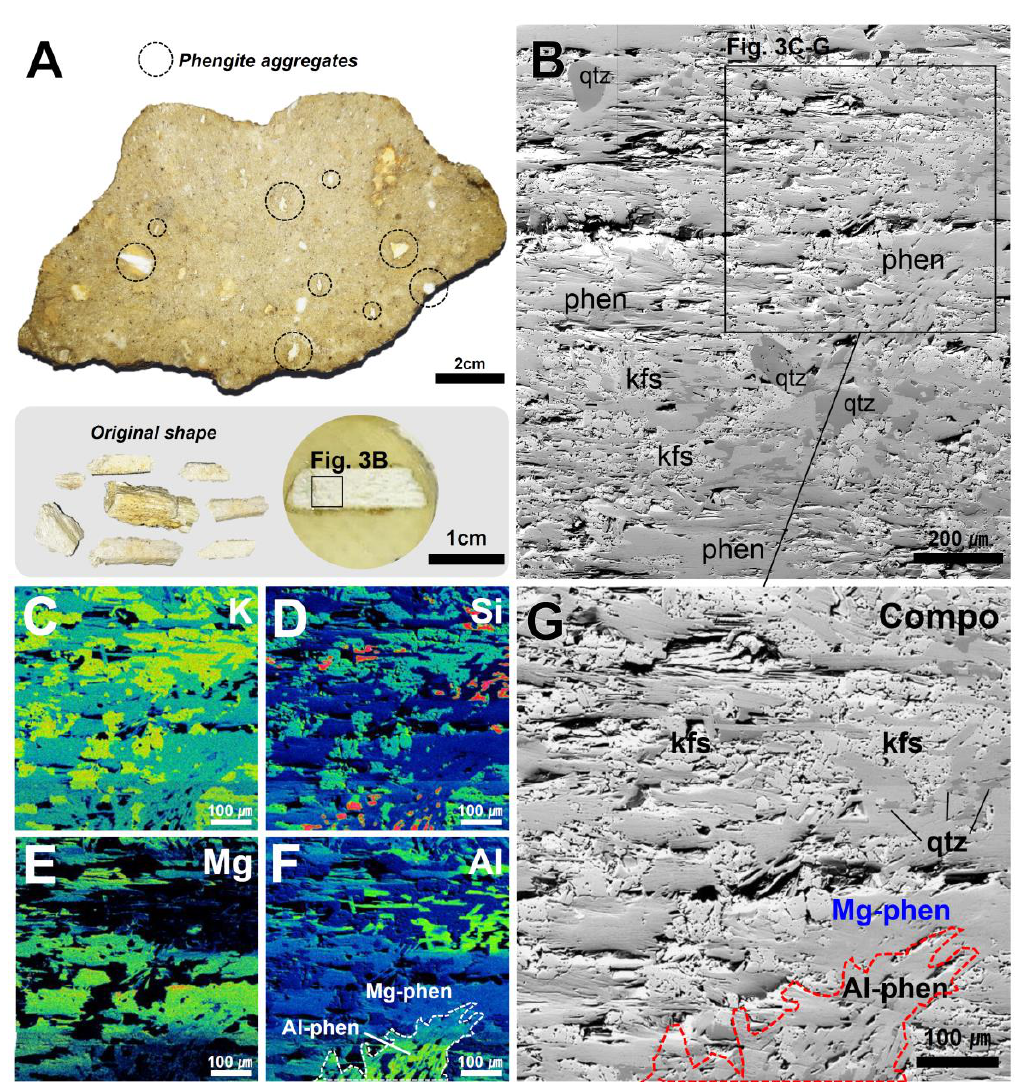
Figure 3. ( A ) Typical phengite aggregates scattered on the polished slab of the typical Haengmae Formation and the separate ones; ( B ) BSE image of the representative phengite aggregate, which is mainly composed of polycrystalline phengite (Type 1) with several hundred micrometers in size with a small amount of quartz and K-feldspar. Element-mapping results of the selected area for ( C ) K, ( D ) Si, ( E ) Mg, and ( F ) Al; ( G ) exaggerated BSE image of the selected part from ( B ). Abbreviations: qtz—quartz; kfs—K-feldspar; Mg-phen and Al-phen—relatively high-Mg/low-Al and low-Mg/high-Al Mg-phengite, respectively.